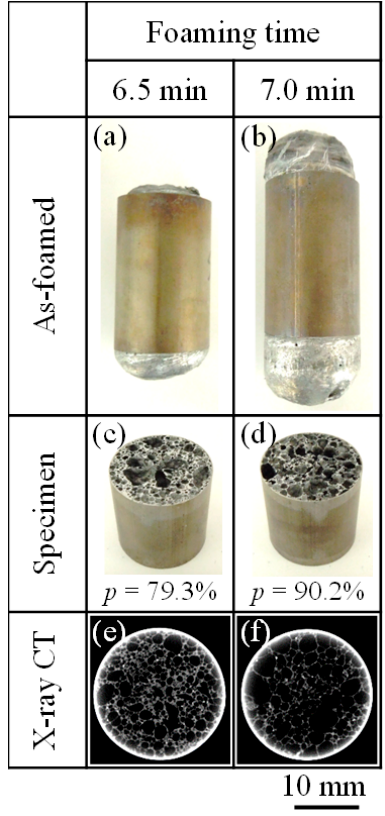
Figure 5. ( a,b ) As-foamed Al foam-filled steel tubes after foaming for 6.5 min and 7.0 min, ( c , d ) Al foam-filled steel tube compression test specimens machined from ( a , b ), respectively. ( e , f ) Their respectively. ( c,d ) Al foam-filled steel tube compression test specimens machined from ( a,b ), cross-sectional X-ray CT respectively. ( e,f ) Their cross-sectional X-ray CT images.